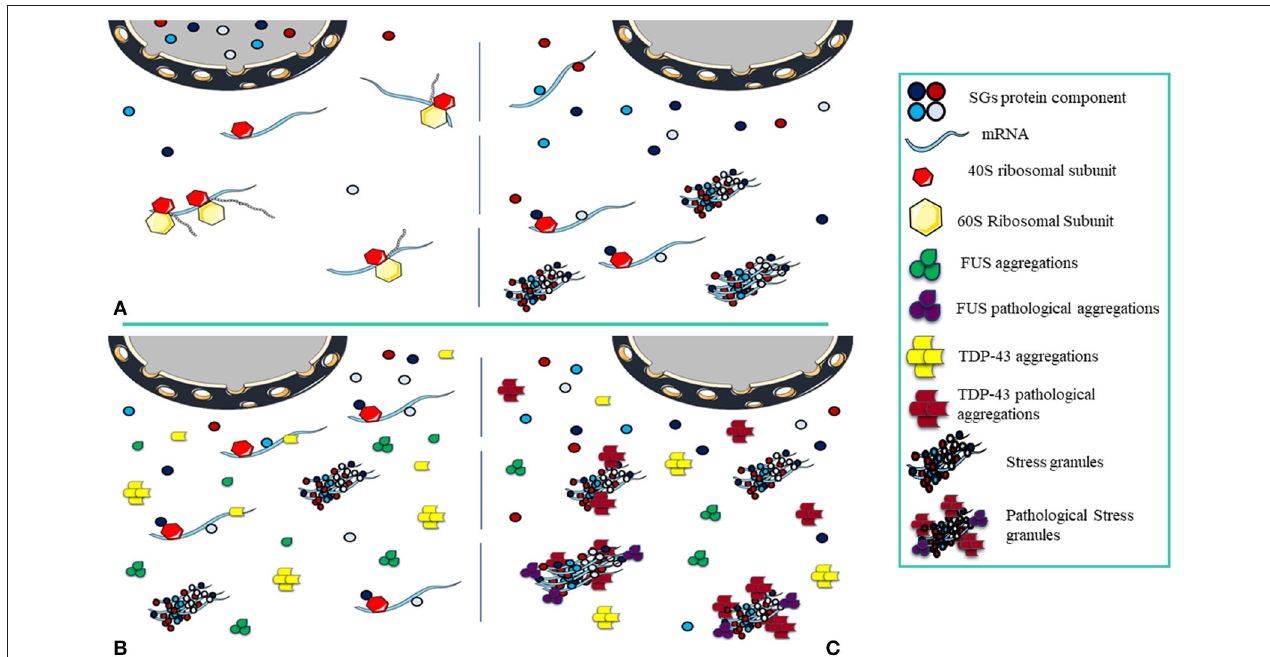
FIGURE 3 | Pathological Stress Granules Formation. (A) The cell is in equilibrium, and as stress arrives, nuclear depletion of SGs components occurs, the translation process halts and the structure of transient SGs is formed. Once the stress is relieved, the cell returns to normal and SGs disassemble. (B) The cell is exposed to acute stress, the components of SGs and protein aggregations (FUS and TDP-43) localize to the cytoplasm. In this condition, FUS and TDP-43 aggregations have not become pathological and do not interact with SGs, the number of SGs decreases as stress is relieved. (C) Under chronic stress, FUS and TDP-43 aggregations become pathological and in interaction with SGs, under the constant presence, pathological effects